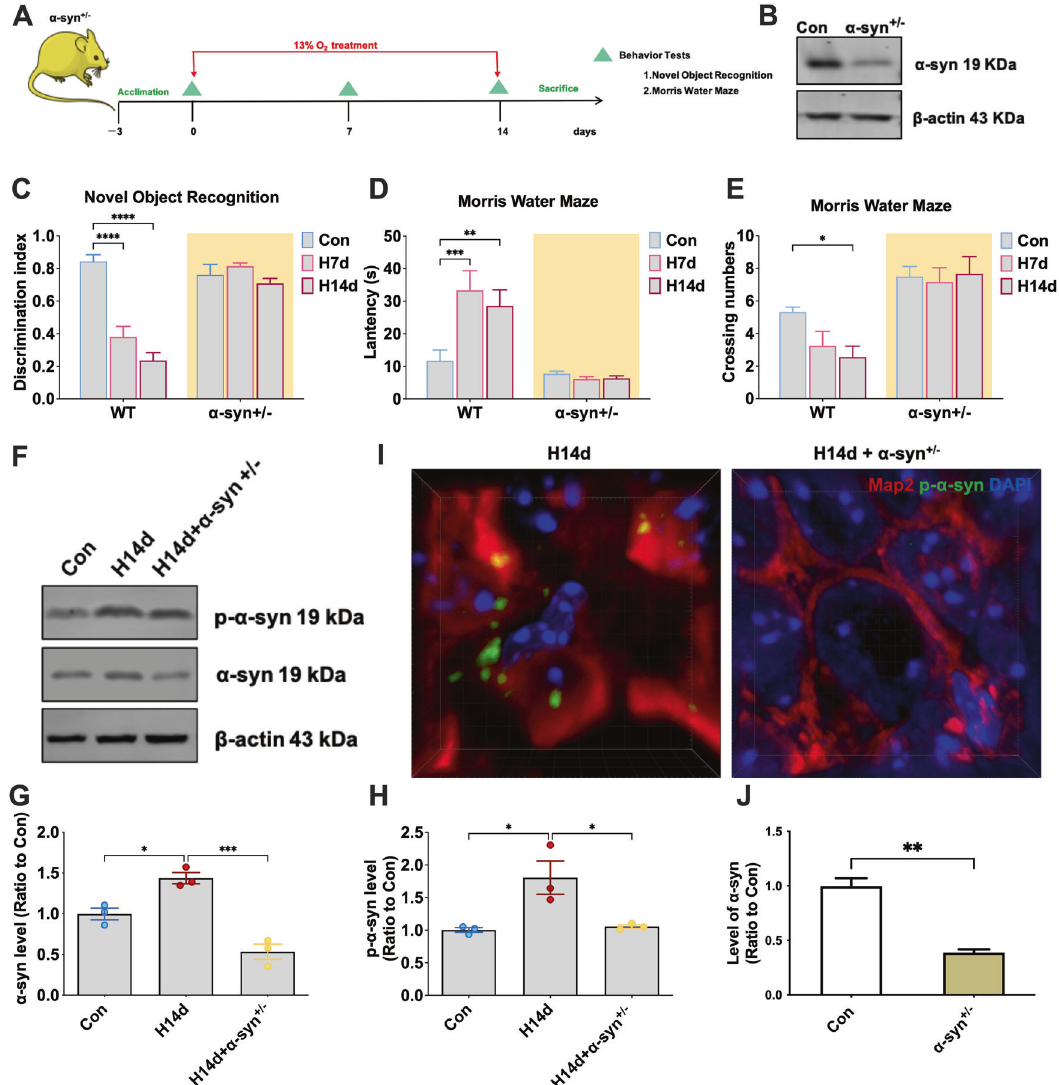
time points. C Detection and statistical analysis of the novel object recognition tests in mice of each group. D , E Detection and statistical analysis of the Morris water maze tests in mice of each group. F – H The levels of p- α -syn and α -syn in the hippocampi of mice in the Con, H14d, and H14d + α -syn + /- groups were detected by western blots with β -actin as the internal reference; Statistical analysis was performed. I The high-power three-dimensional imaging of p- α -syn immuno fl uorescence. In C – E , data are expressed as the mean ± SEM (two-way